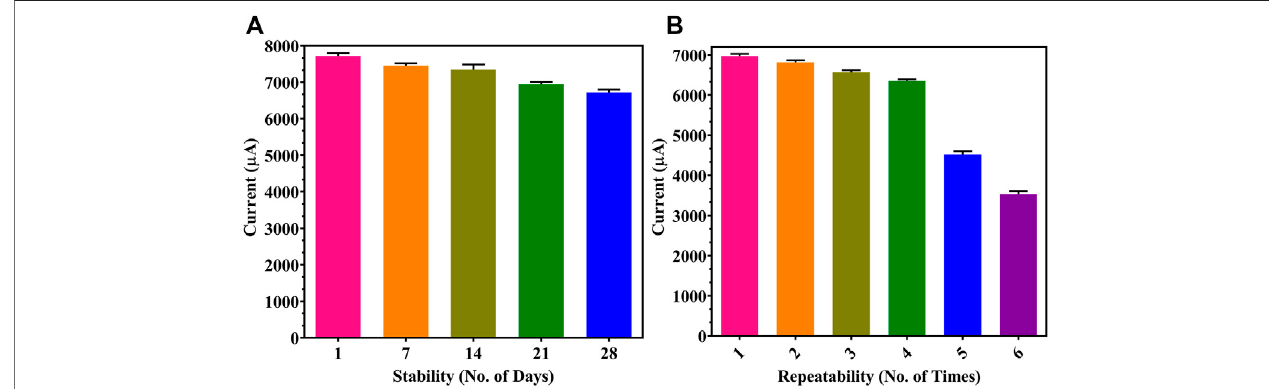
FIGURE 7 | Immunosensor performance: (A) storage stability for 1 month at 1-week gaps; (B) repeatability studies on individual modi fi ed FTO